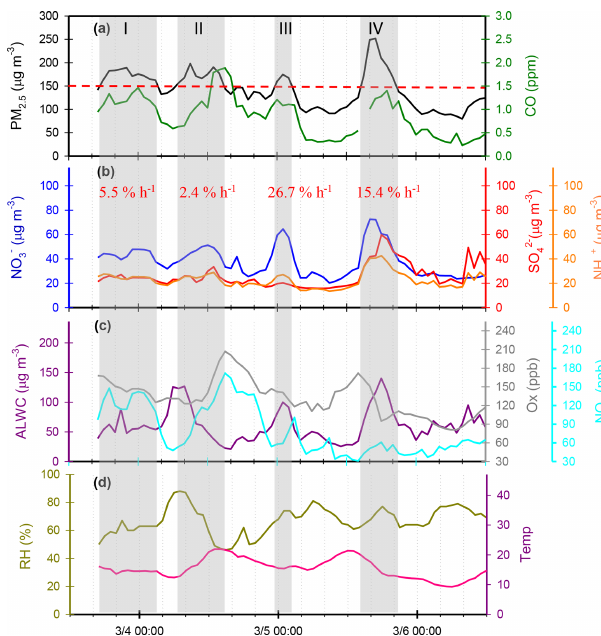
Figure 8. Time series of concentrations in (a) PM 2 . 5 mass and CO, (b) SIA species (NO − , SO 2 − and NH + ), (c) ALWC, O x and NO 2 , 3 4 4 and (d) RH and T in Nanjing City from 3 to 6 March 2016. The grey shadows denote PM 2 . 5 episodes. The red numbers represent NO − production rate during the PM 2 . 5 episodes. 3